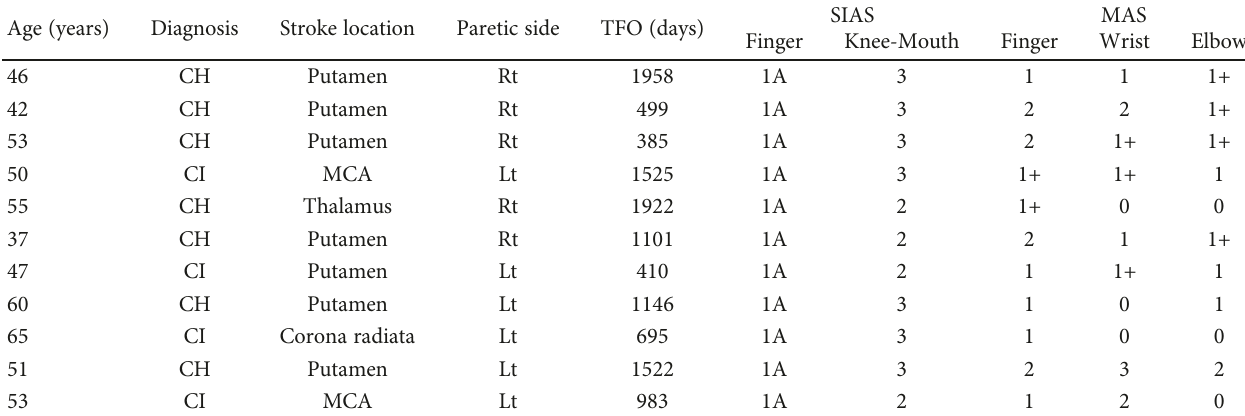
Table 2: Clinical details of participants in study